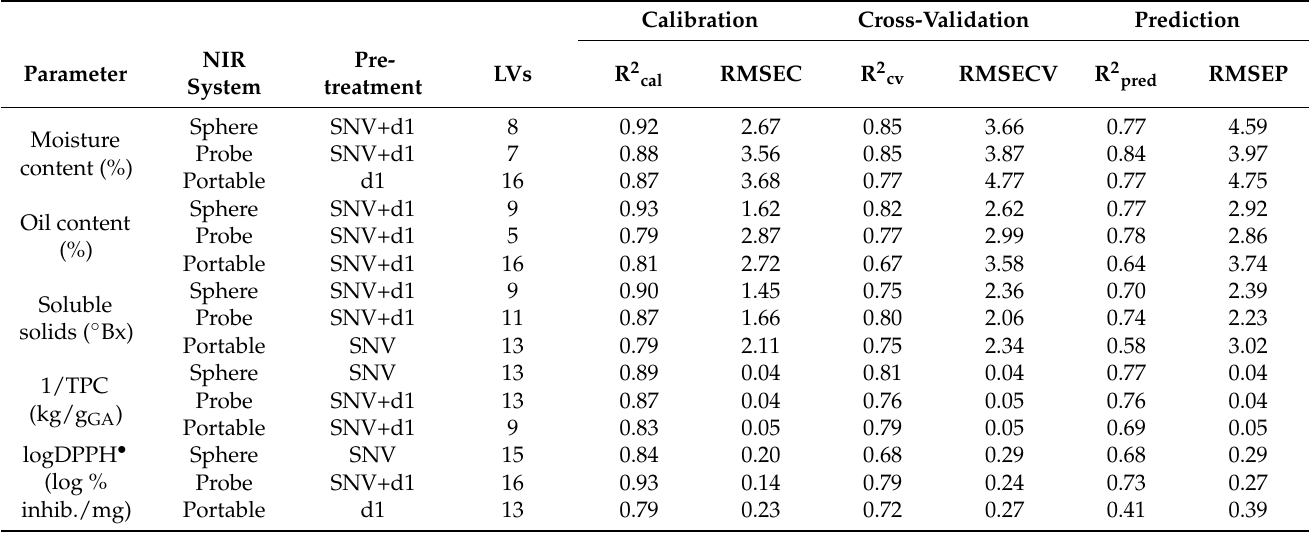
Table 1. Figures of merit of the best PLS regression models for olive chemical parameter prediction based on spectro- scopic